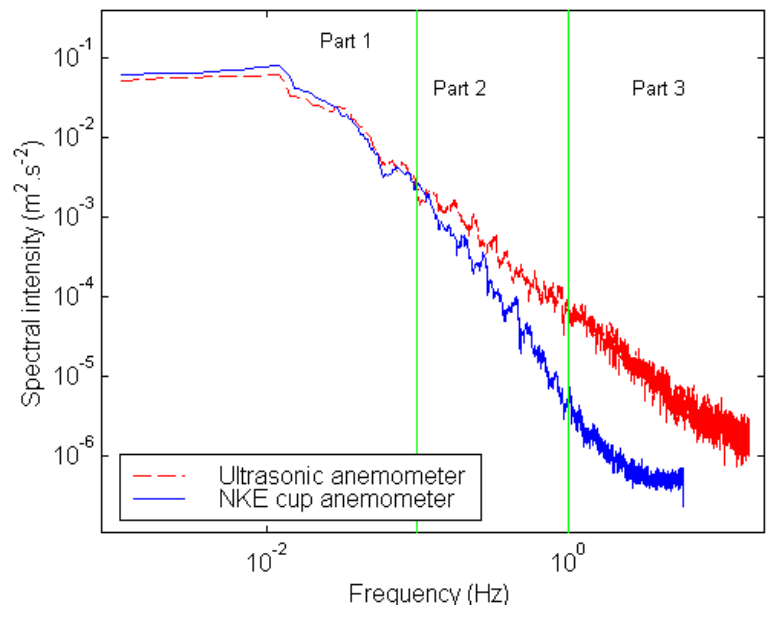
Fig. 4. Spectral intensities of the data from the ultrasonic and the cup anemometers. Sample 4 of 30 December 2002.